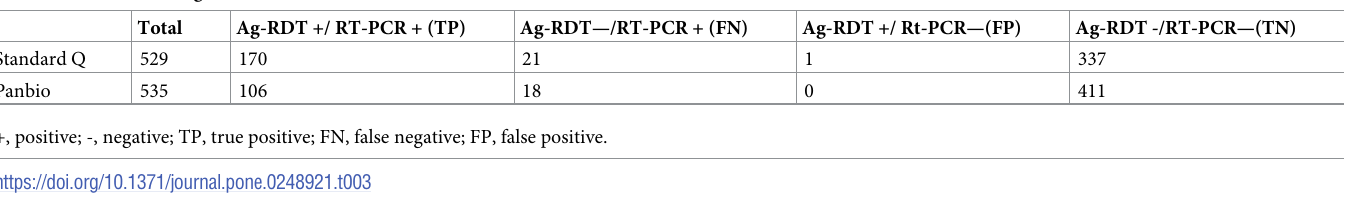
(97.8%) were symptomatic upon presentation at the testing centre, with only 3 reporting no symptoms. Symptoms information was missing for 4 patients. The study population tested with the Standard Q was younger than that tested with the Panbio assay (34.9 ± 10.9 vs 38.5 ± 13.6 years, respectively, p < 0.001) and DPOS differed slightly (2.9 ± 1.5 vs. 2.6 ± 2.0 days, respectively, p = 0.0125). Ct-values did not differ significantly between the two groups (p = 0.450): 22.6 (SD ± 4.9) in the Standard Q group vs. 22.4 (SD ± 5.4) in the Panbio group, corresponding to 1.7E7 and 1.9E7 SARS-CoV-2 RNA copies/mL, respectively. The RT-PCR positivity rate was 23.2% and 36.1% for the population tested with the Panbio and the Standard Q, respectively, corresponding to an increase in the overall PCR positivity rate and reflecting the rapidly increasing local incidence during the time of this study. The overall test performance for the Standard Q was 89.0% SN (95%CI: 83.7–93.1) and 99.7% SP (95%CI: 98.4–100%). The overall test performance for the Panbio assay was 85.5% SN (95%CI: 78.0–91.2) and 100% SP (95%CI: 99.1–100) ( Table 2 ). The absolute numbers of positive and negative detections per method (by RT-PCR and Ag-RDT) and number of true positive, false negatives, false positives and true negatives can be found in Table 3. Ct-values of samples with positive Ag-RDT results ranged from 14.2–34.0 and 14.4–34.2 for Panbio and Standard Q (p = 0.1766), respectively, while Ct-values of samples of samples that tested falsely negative by Ag-RDT ranged from 16.0–39.7 and 19.8–37.4 (p = 0.7998), respec- tively. Median Ct-values of Ag-RDT positive samples (Panbio: 20.4, IQR: 18.1–23.8; Standard Q: 21.2, IQR 18.6–24) were lower than those of Ag-RDT negative samples (Panbio: 30.5, IQR: 27–35.9; Standard Q: 30.4, IQR: 25.7–33.9) ( Fig 1 ). Furthermore, we evaluated overall Ag- RDT results in relation to Ct-values/viral load as well DPOS ( Fig 2 ). False-negative results occurred in both assay across all DPOS. We compared SN and SP between the two Ag-RDTs and concluded that we could accept, with high probabilities, (respectively likelihood ratio of BF = 10.2 and 11.9) the hypothesis of 01 equivalent SN and SP. Based on this, a combined SN of 87.6% (95%CI: 83.5–91.0) and a com- bined SP of 99.9% (95%CI: 99.3–100) for both Ag-RDTs were calculated with a positive predic- tive value of 99.6% (95%CI: 98.0–100) and a negative predictive value of 95.0% (95%CI: 93.3– 96.5). In order to identify subpopulations in which maximal SN could be reached with these tests, we analyzed SN by DPOS, Ct-values as determined by RT-PCR, type of symptoms, comorbidities, and previous contact with a confirmed SARS-CoV-2 infection.